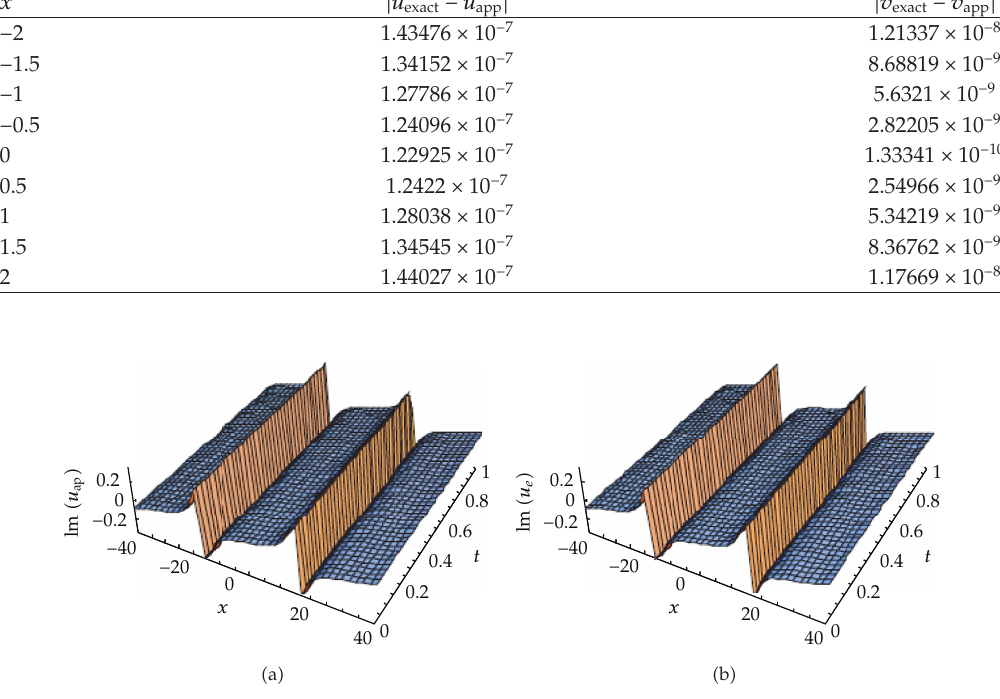
Figure 3: The approximate solution (cid:2) 5.19 (cid:3) shown in the figure (cid:2) a (cid:3) in comparison with the exact solution